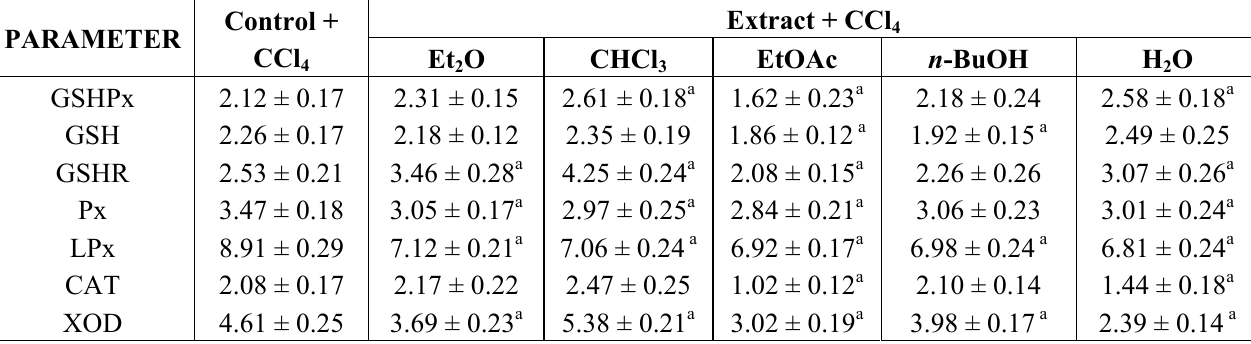
Table 4. Effect of M. melissophyllum leaves extracts and CCl biochemical